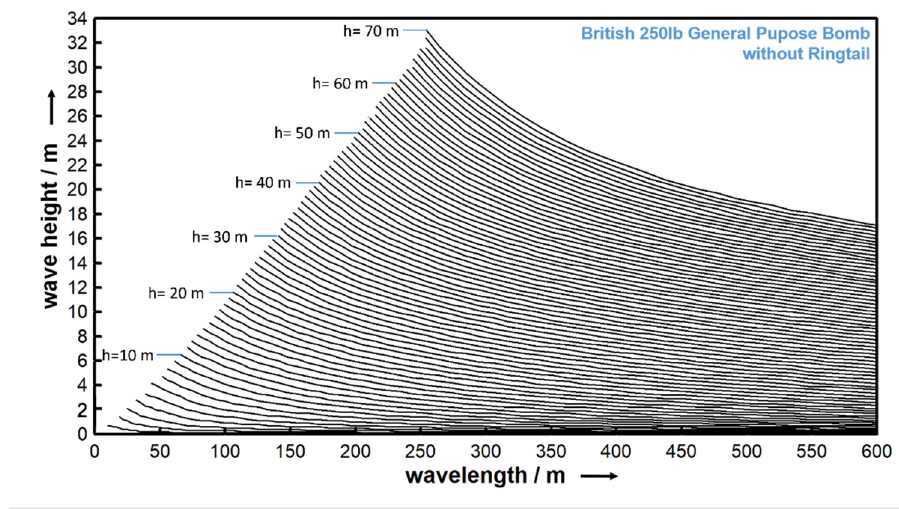
Figure 5. Critical conditions for the British 250-pound general purpose bomb without a ring tail. In wave conditions above or right of the graph, objects are mobilized; left and below, they do not get